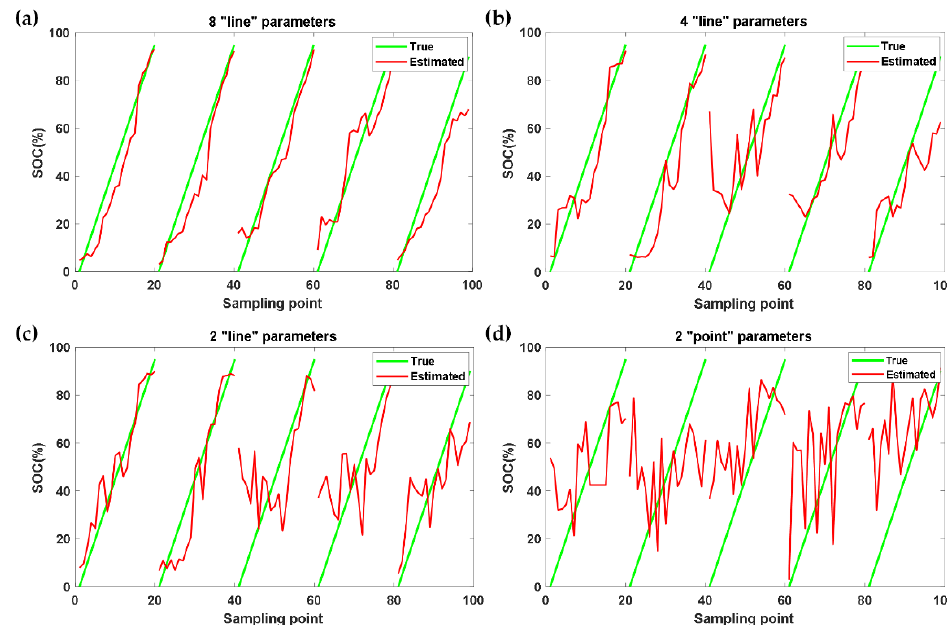
Figure 9. SOC estimation result during battery charging process. (( a – c ) are the SOC estimation results using 8, 4, and 2 “line” parameters, respectively; ( d ) is the SOC estimation result using 2 “point” parameters). Table 7. Battery SOC estimation result.